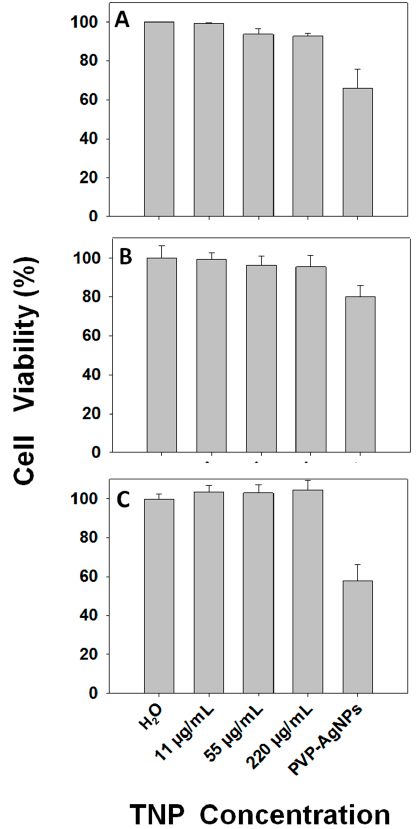
Figure 4. Viability of HEK293 ( A ); HepG2 ( B ); and THP-1 ( C ) treated with TNP at indicated concentrations or silver nanoparticles (PVP-Ag, 50 μ g/mL) for 24 h. Values are the means of at least three independent experiments ± SD.